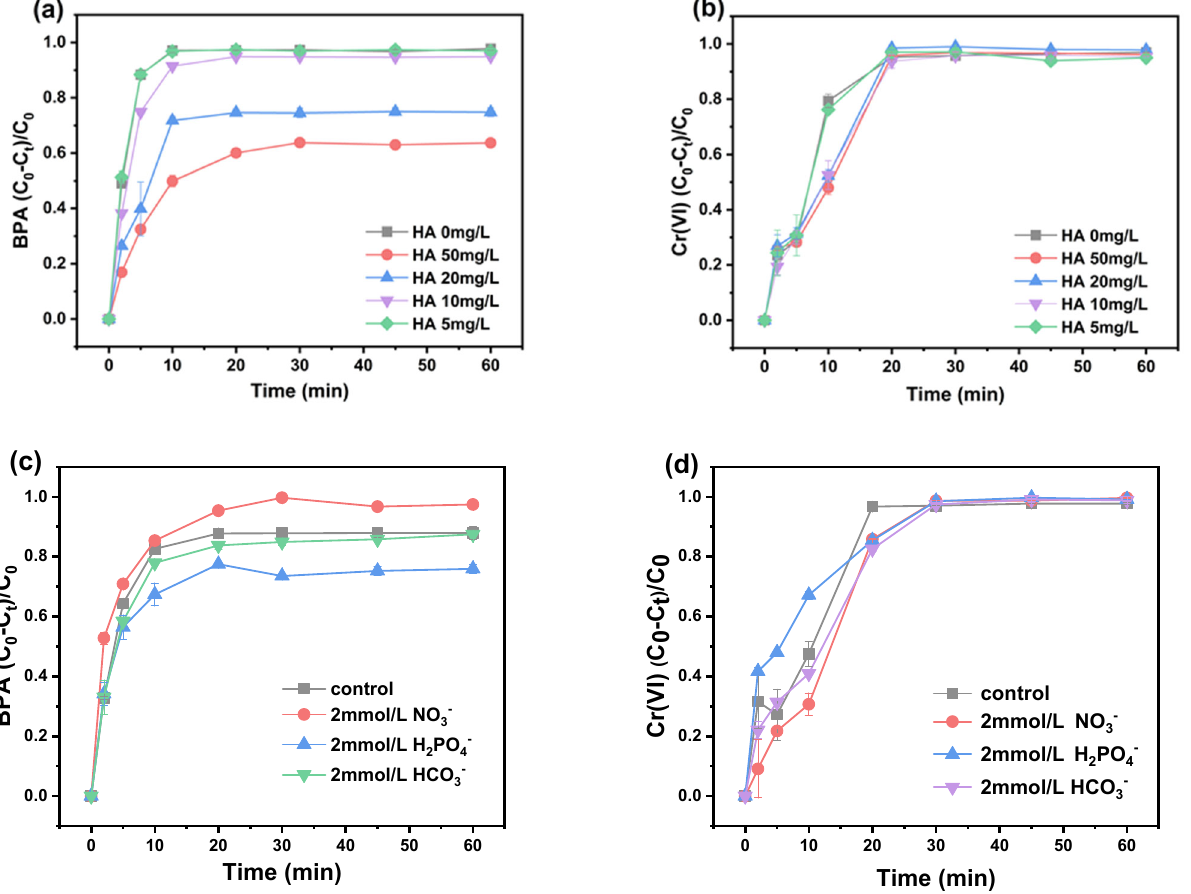
Figure 2. Effect of ( a , b ) humic acid and ( c , d ) inorganic anions on synchronous removal of BPA and Cr(VI) by S ‐ nZVI .